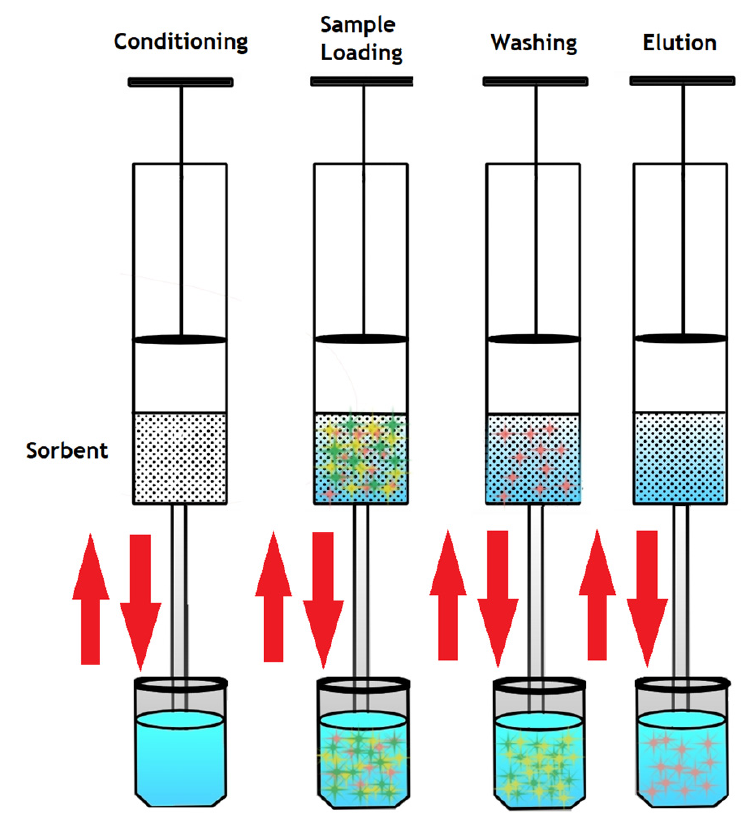
Figure 2. Representation of the MEPS protocol.